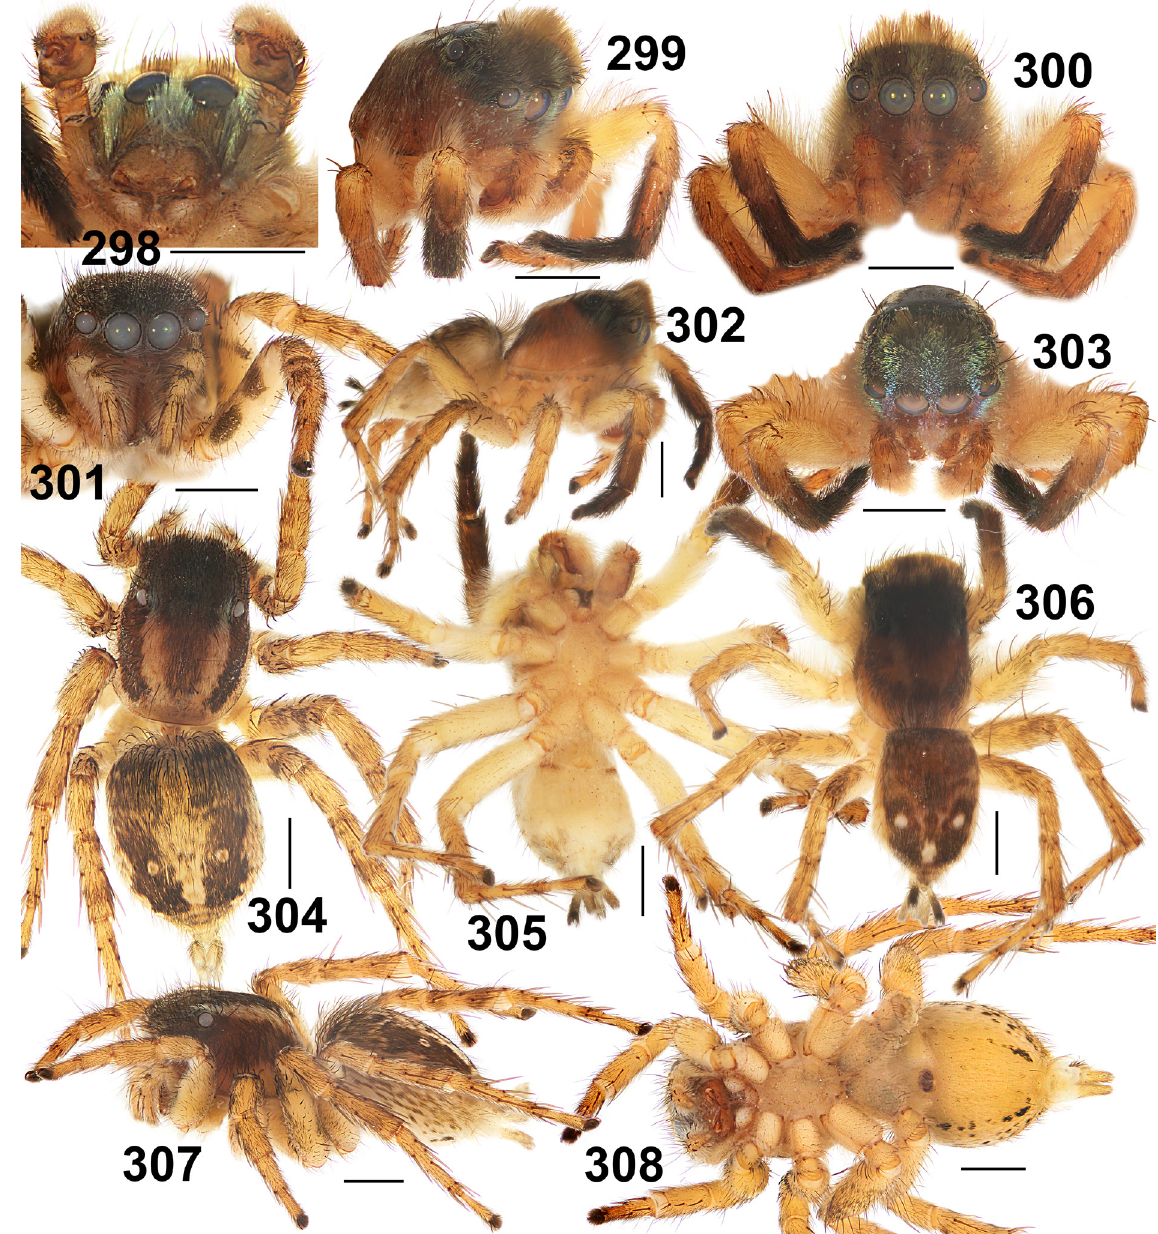
Figs 298–308. Stenaelurillus jocquei sp. nov. , light form, general appearance, ♂♂ (298–300, 302–303, 305–306) and ♀♀ (301, 304, 307–308) . 298–301 , 303–304 , 307–308 . Paratypes from Cameroon (Faro GR). 302 , 305–306 . Holotype. Scale bars: 1